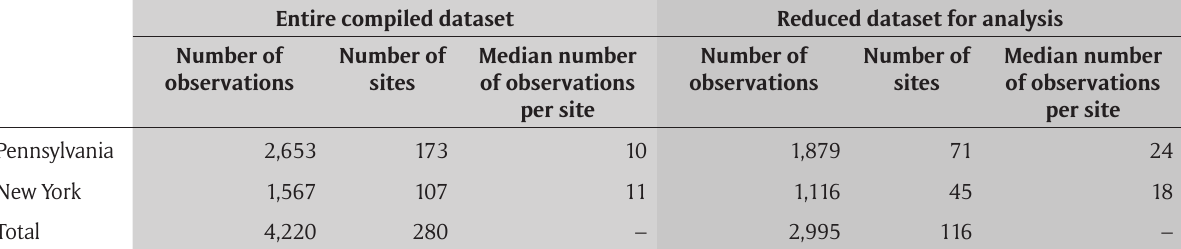
Table 2: Number of observations and sites in the entire and reduced datasets.